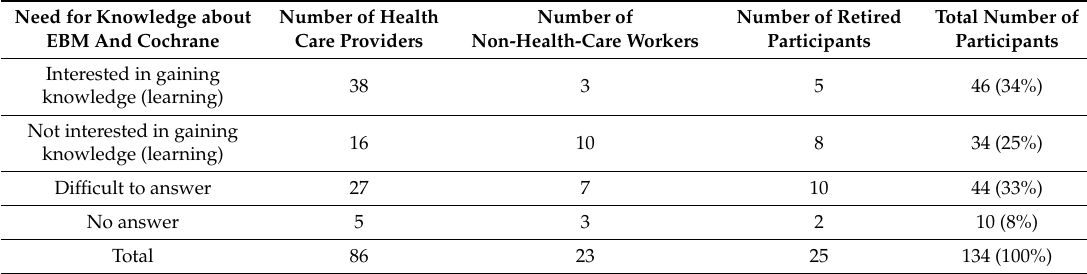
Table 11. Need for knowledge about evidence-based medicine (EBM) and